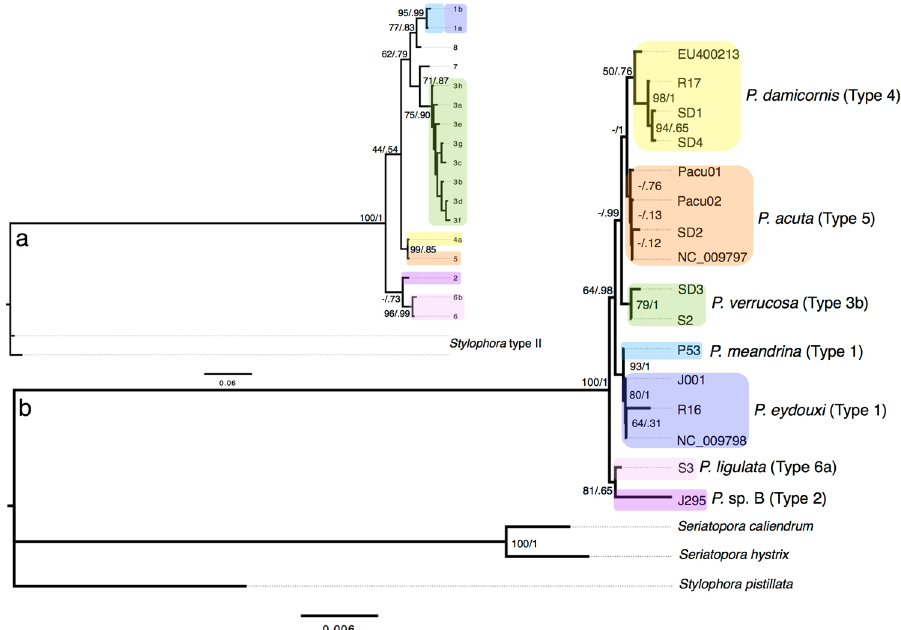
Figure 2. Phylogenetic analysis of mtORF and mitochondrial genomes. Reanalyzed data from ( a ) Pinzón et al . 2 : maximum likelihood and Bayesian (ML/B) phylogenetic analysis of the mtORF alignment of 382 bp. Tip labels indicate mtORF haplotype after Pinzón et al . 2 . ( b ) Maximum likelihood and Bayesian (ML/B) phylogenetic analysis of pocilloporid mitochondrial genomes (17,884 bp) (bottom). mtORF type designation after Pinzón et al . 2 and species names after Schmidt-Roach et al . 11 (Table 1). Scale bar represents substitutions per site. Pocillopora taxa are in yellow: Pocillopora damicornis ; orange: P. acuta ; green: P. verrucosa ; light blue: P. meandrina ; dark blue: P. eydouxi ; light purple: P. ligulata ; dark purple: P . sp. B. and three outgroups, Stylophora pistillata , Seriatopora caliendrum and Seriatopora hystrix .